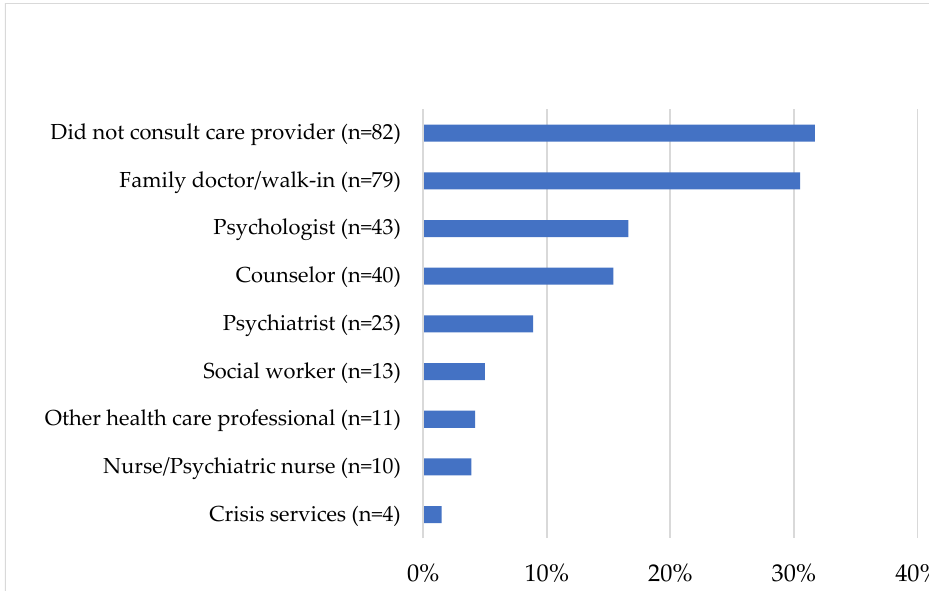
Figure 5. Prior support-seeking.